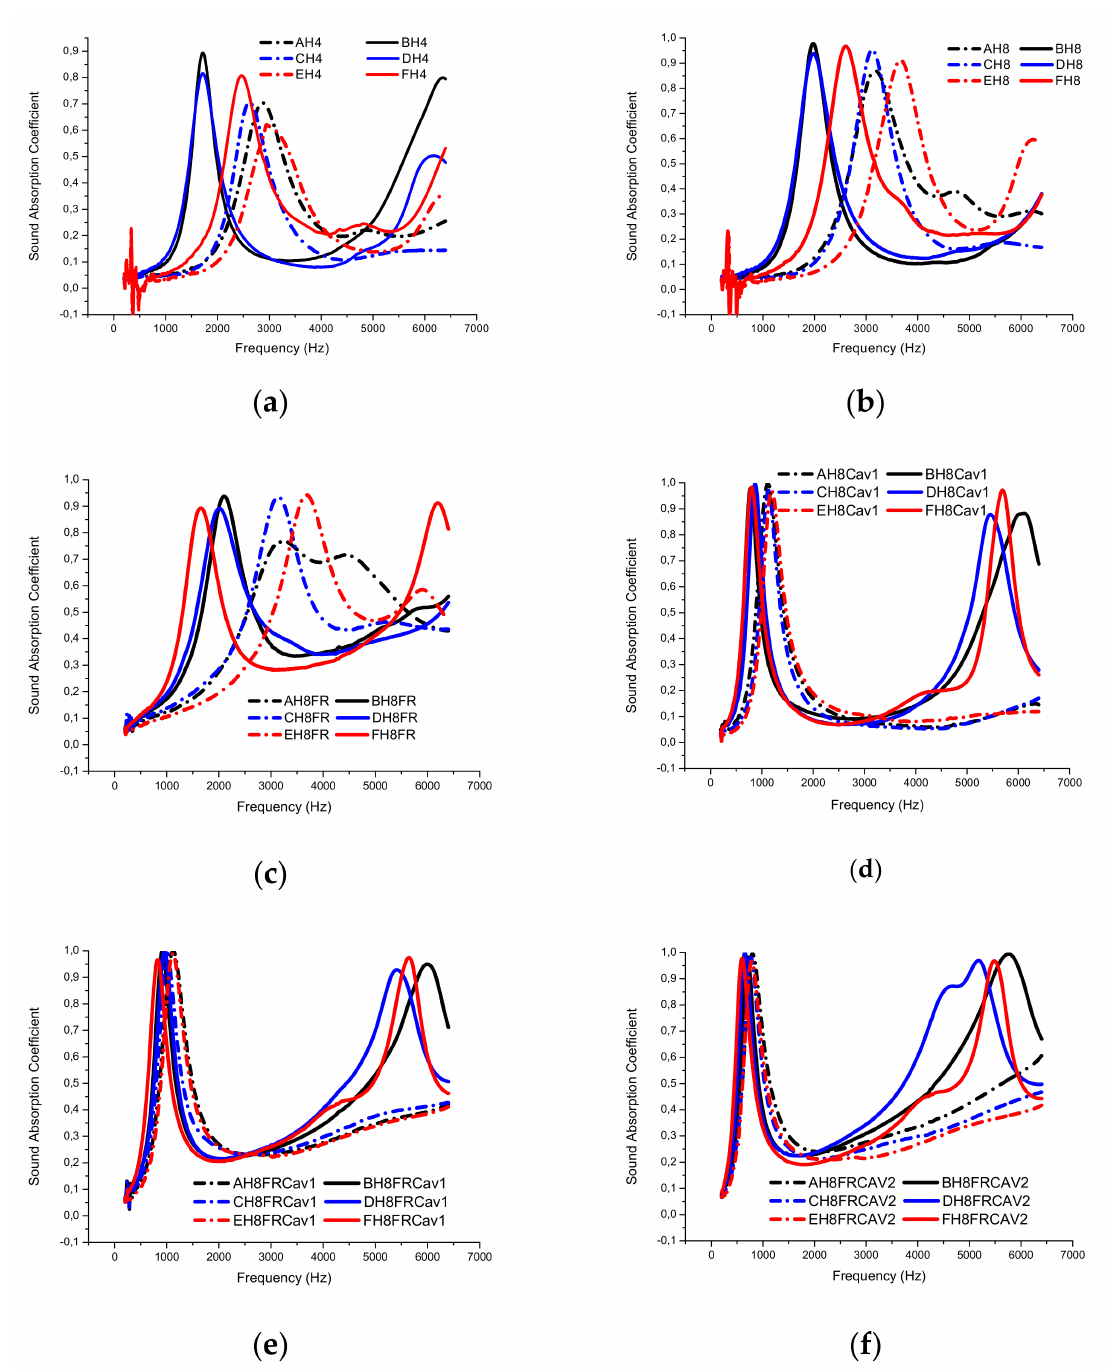
Figure 4. Composite shell absorption coefficient with: ( a ) 4 resonators; ( b ) 8 resonators; ( c ) fibrous layers; ( d ) 10 mm cavity; ( e ) fibrous layer and 10 mm cavity; ( f ) fibrous layer and 20 mm